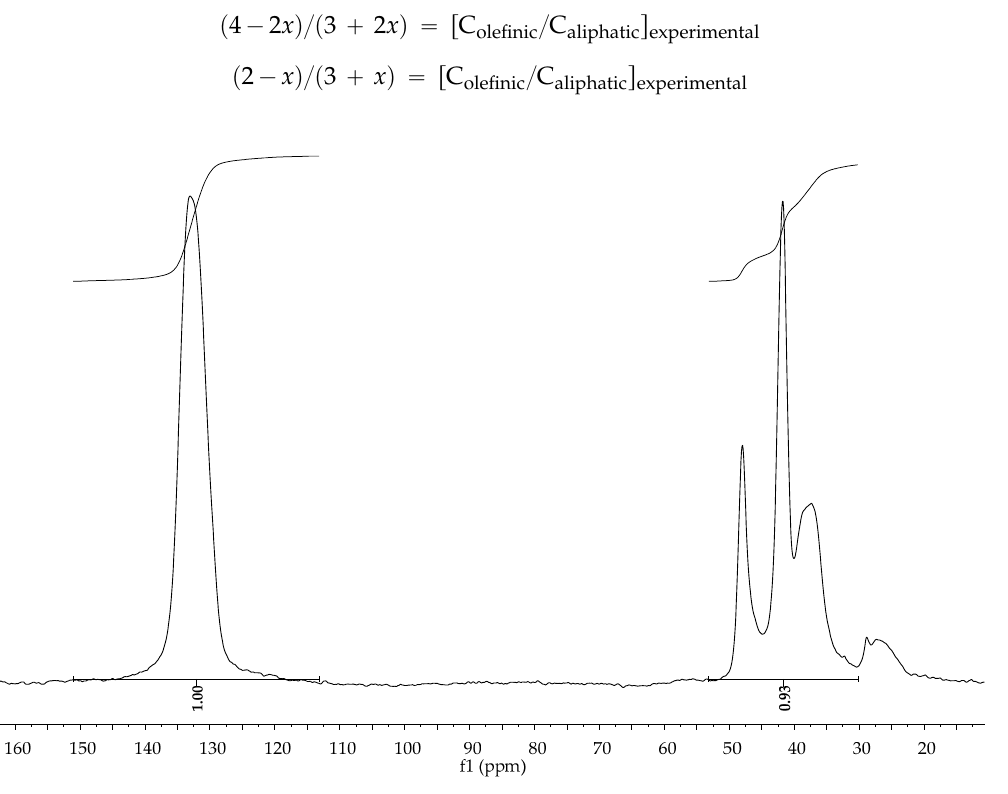
Figure 2. 13 C Cross Polarization Magic Angle Spinning (CPMAS) spectrum of PNBD obtained from the Figure reaction of 1 /AgBF 4 /NBD (Table 5, entry 4) in CH 2 Cl 2 .